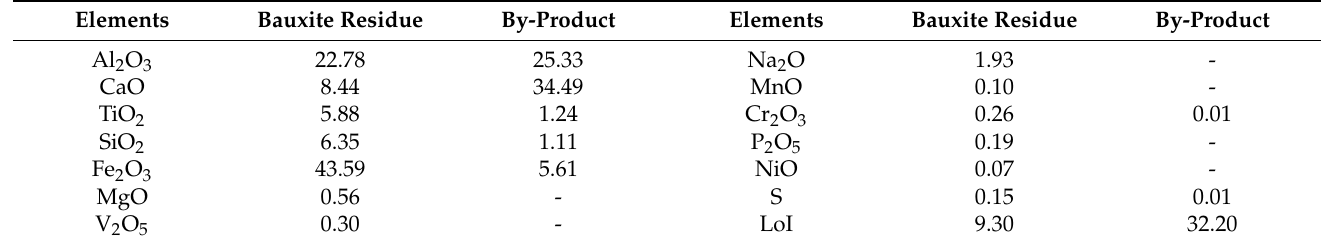
Table 1. XRF quantitative analysis of bauxite residue and by-product